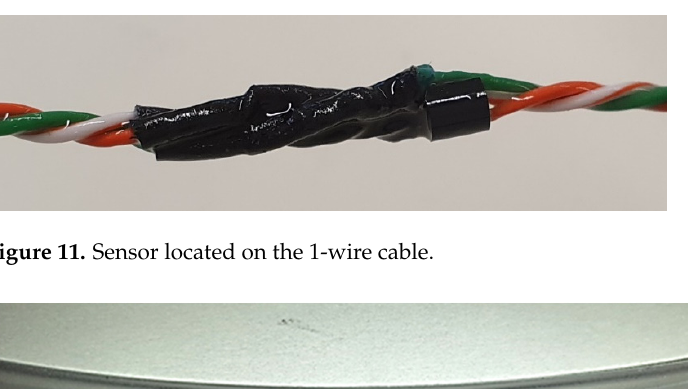
Figure 10. DS18B20 sensor connection diagram to the 1-wire bus.